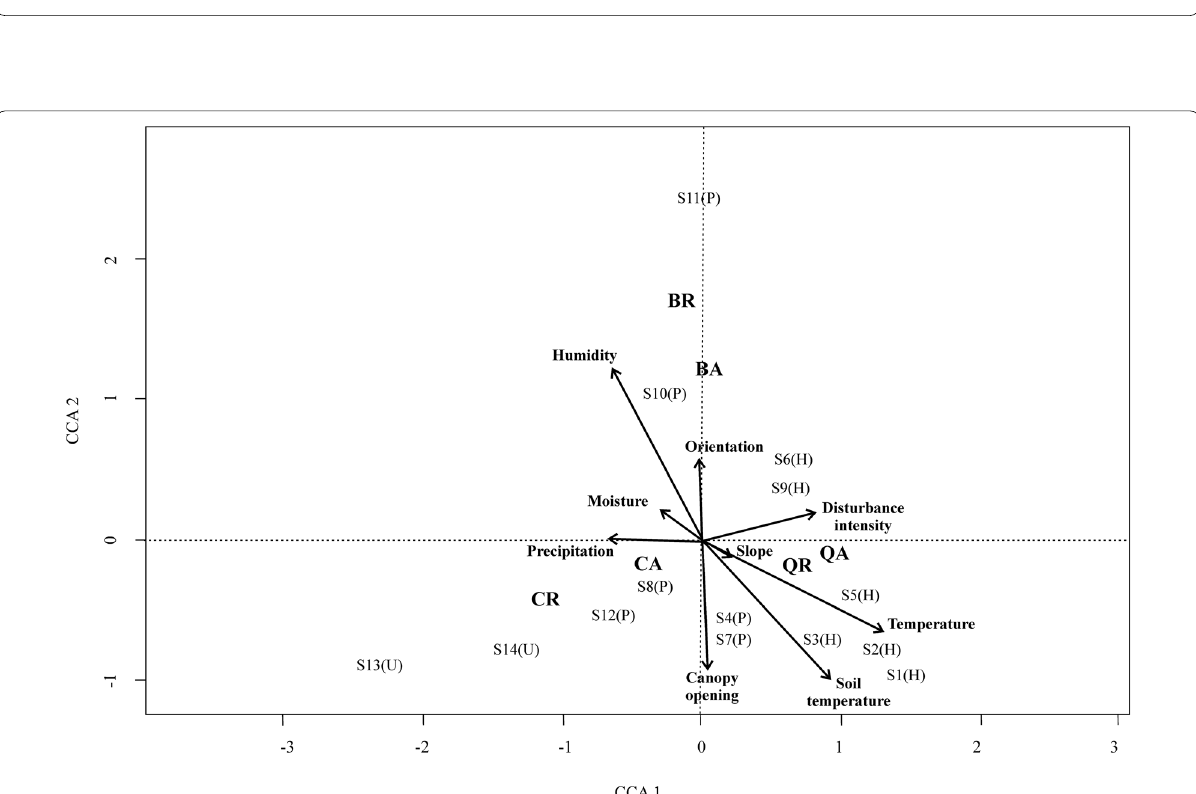
1.96 indicate a greater recruitment according to the regime of disturbance, +